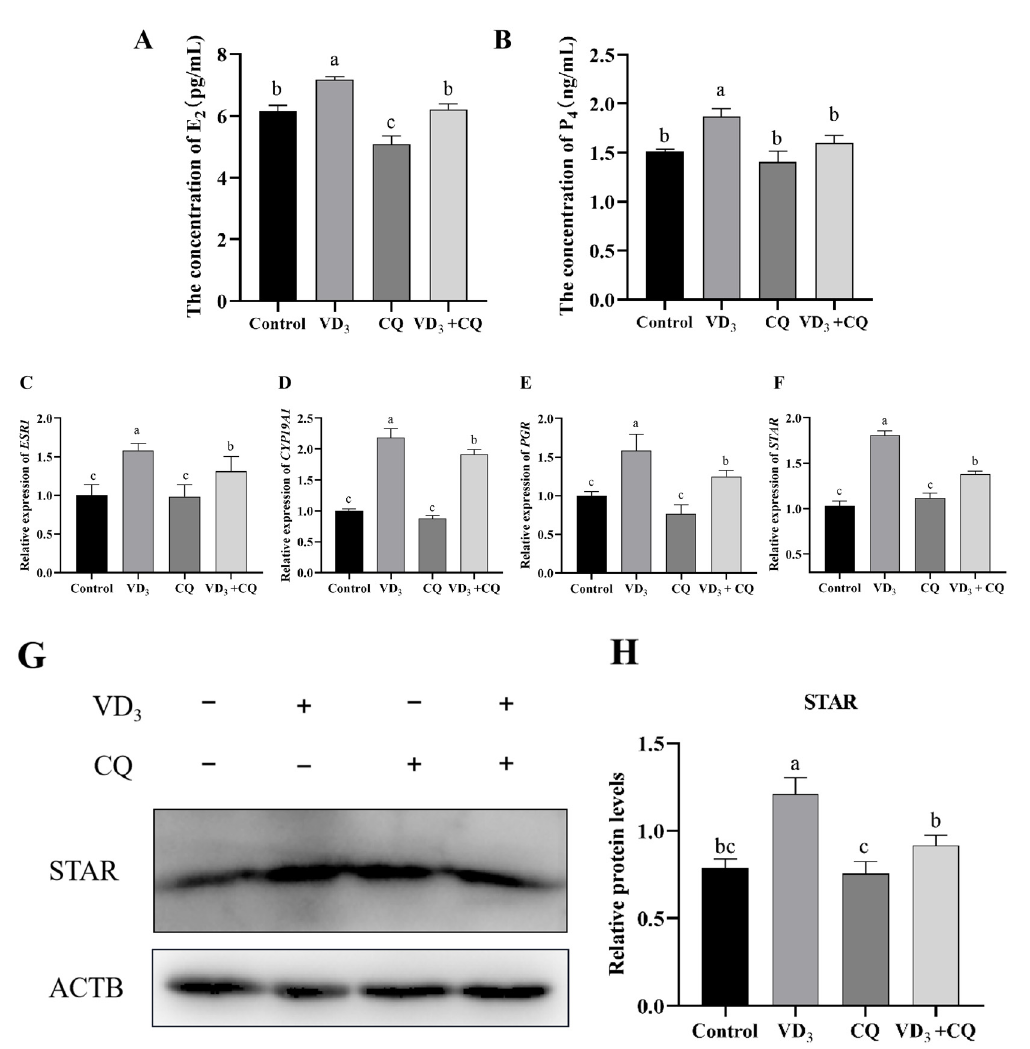
Figure 5. The effects of 1 α ,25(OH) 2 D 3 on steroid hormone secretion. ( A ) The content of E 2 and P 4 ( B ) production in PGCs. The relative gene expression of ESR1 ( C ), CYP19A1 ( D ), PGR ( E ), and STAR ( F ) in PGCs. Western blotting was used to identify the protein level ( G ), and the protein contents of STAR ( H ) were evaluated in PGCs. VD 3 : 1 α ,25(OH) 2 D 3 . CQ: chloroquine. Different letters on the bar indicate a significant difference. Data are means ± SE of three independent replicates ( p <